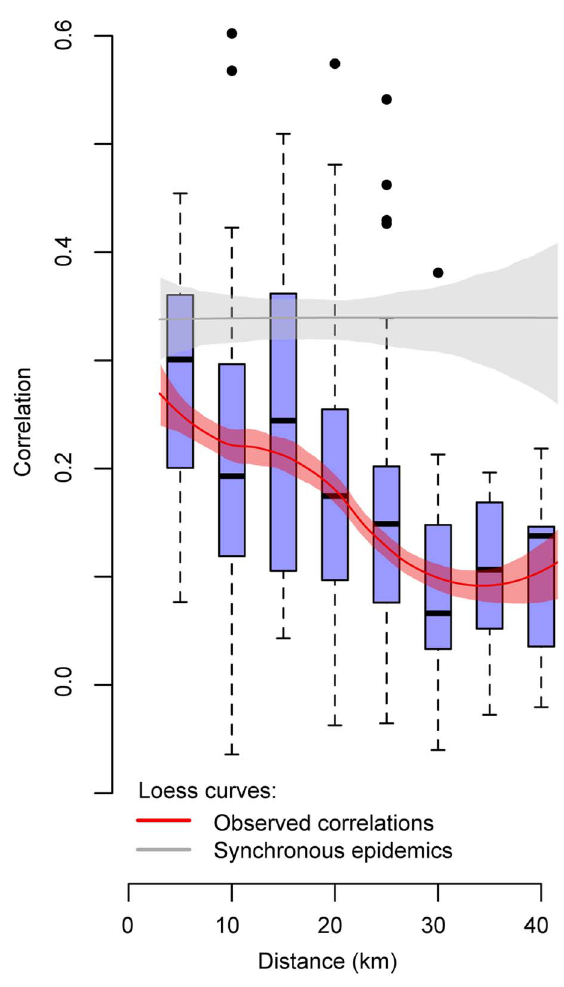
Figure 3. Correlation between epidemic curves. Box plots of the correlation between the epidemic curves of pairs of village clusters and the distance between them (blue). Only village clusters with at least 40 cases were used in this analysis. Loess curves of the same data with 95% confidence intervals generated through 500 bootstrapped resamples (red). The grey line represents the correlation under the theoretical scenario of complete synchrony in case distribution across the whole district (generated by randomly reassigning thedates that cases occurred between all the cases, keeping the total number at any time point fixed).